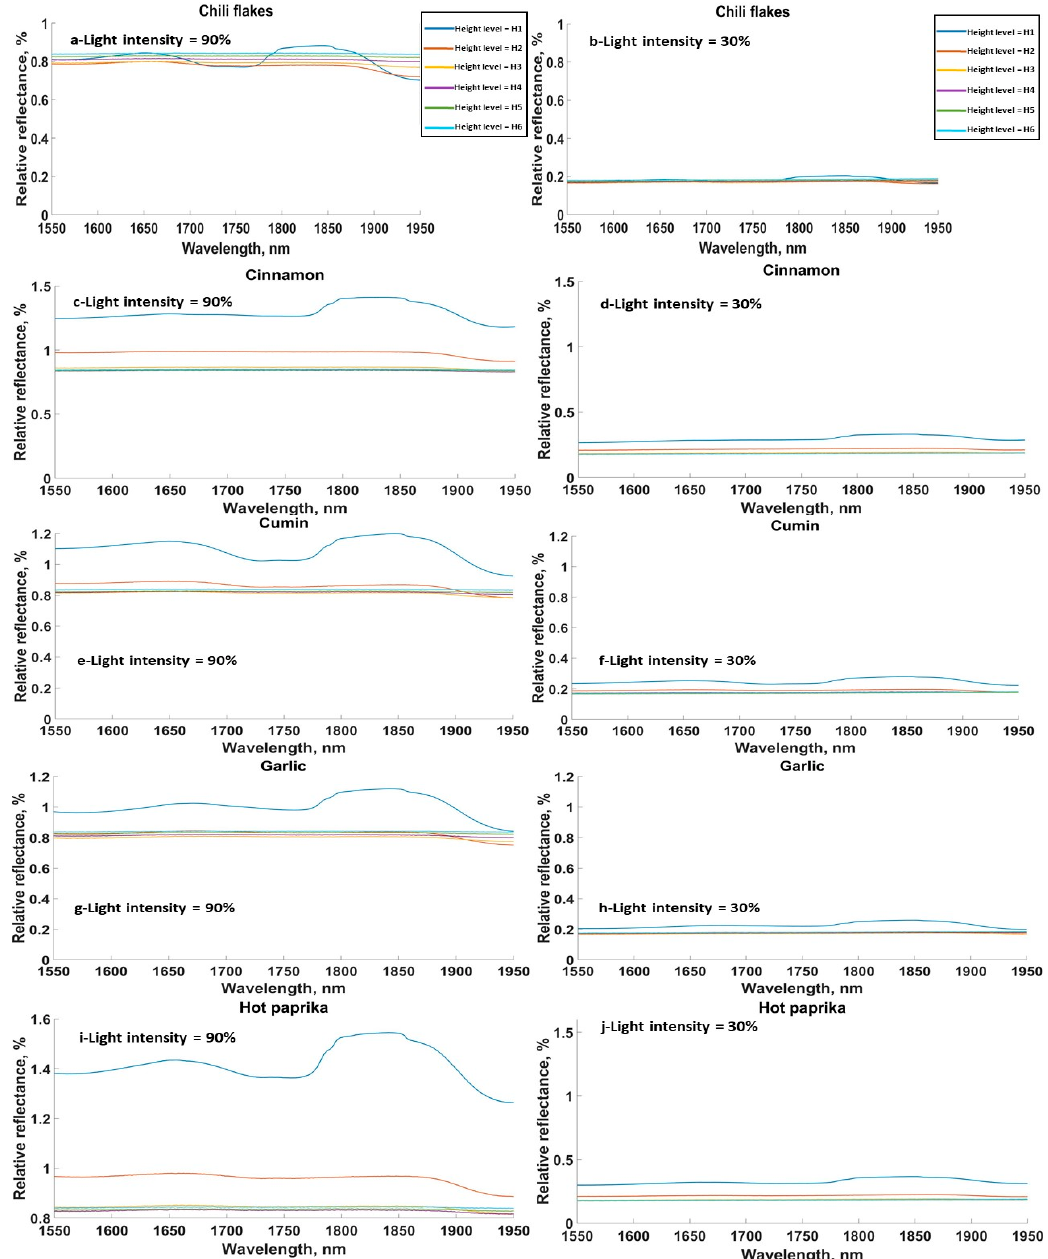
Figure 3. Relative reflectance for all height levels and the minimum and maximum light intensities, 90% and 30%, for ( a , b ) chili flakes, ( c , d ) cinnamon, ( e , f ) cumin, ( g , h ) garlic granules, ( i , j ) hot paprika. Height levels: H1 = 3 cm, H2 = 4.5 cm, H3 = 6 cm, H4 = 7.5 cm, H5 = 9 cm, H6 = 10.5 cm.